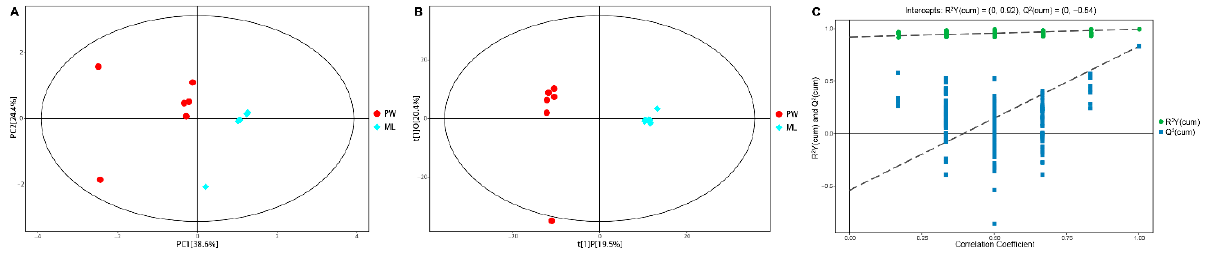
Figure 2. PCA score plot ( A ) and OPLS-DA score plot ( B ) with corresponding permutation test plot ( C ) derived from the GC/TOF-MS metabolite profiles of C. formosanus workers. Red and blue dots indicate metabolite profile of termites fed a pinewood (PW) diet and a M. micrantha leaves (ML) diet, respectively; a dot represents one replicate ( n = 6); the circle represents the 95% Hotelling’s T-squared ellipse.